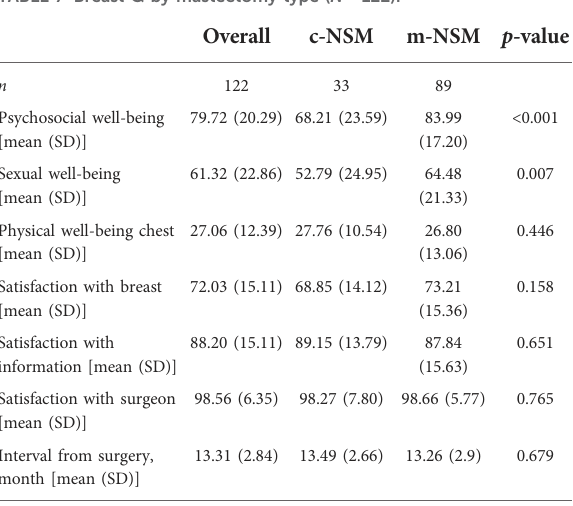
TABLE 7 Breast Q by mastectomy type ( N